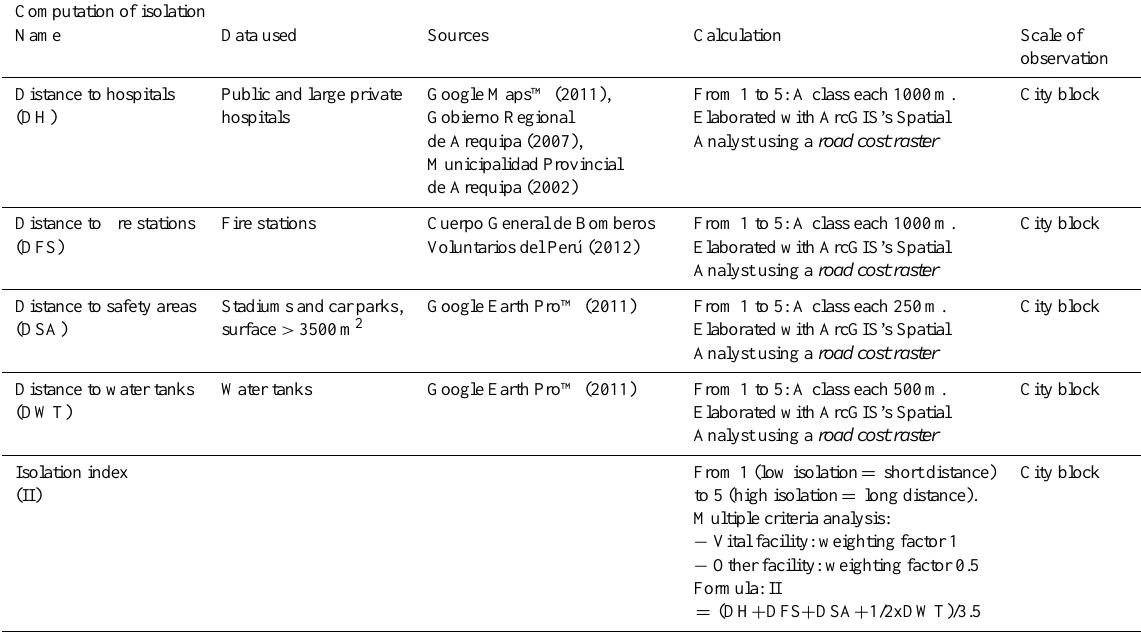
Table 6a. Evaluating the “isolation” factor (see text for discussion). The measurement of “isolation” has been carried out at the city-block scale. All variables are divided into five classes and mapped (Fig. 10). For the computation of overall isolation (Table 6a), a weighting factor equal to 1 is assigned to critical facilities such as hospitals, fire stations and safety areas, while a weighting factor equal to 0.5 is assigned to non-essential facilities such as water tanks. The map of “isolation” for the whole city of Arequipa is shown in Fig. 11. Starting from the computation of the isolation index (II), the mapping takes into account road conditions and natural constraints (rivers and bridges). Poor road conditions result in additional travel time to facilities and an increase in isolation (Table 6b).